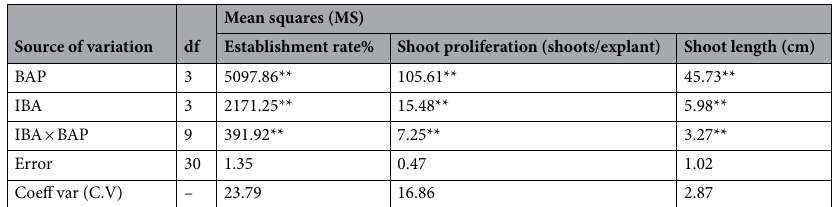
Table 1. The effect of BAP and IBA treatment on the number of shoots per explant and shoot length (cm) of R. coriaria. *; **Significant at the 0.05, 0.01 probability level respectively.